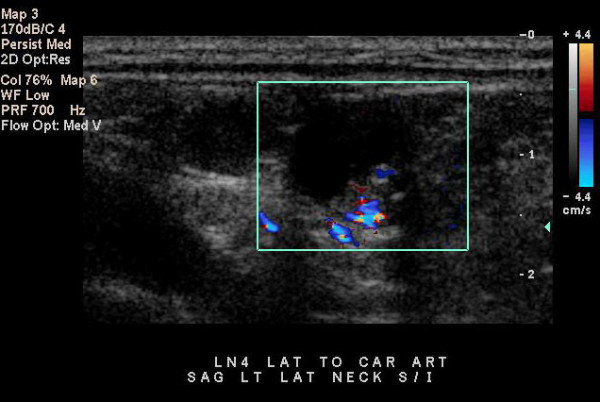
Ultrasound image demonstrates a mixed cystic and solid appearing lateral cervical lymph node in a patient with previous thyroidectomy for papillary thyroid carcinoma.